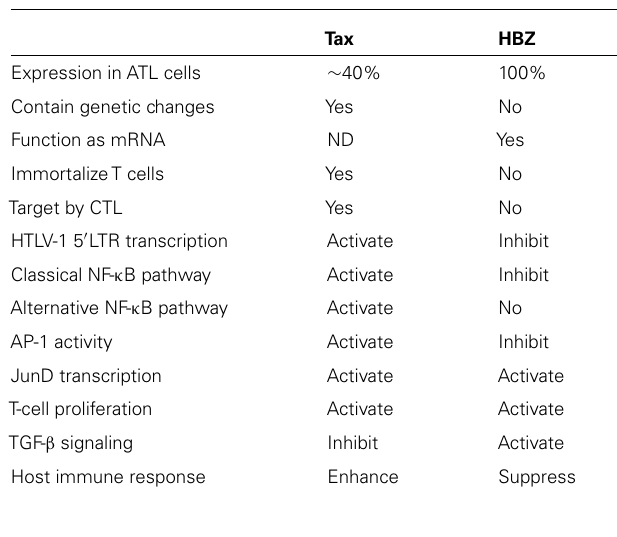
Table 1 | Character and regulatory function ofTax and